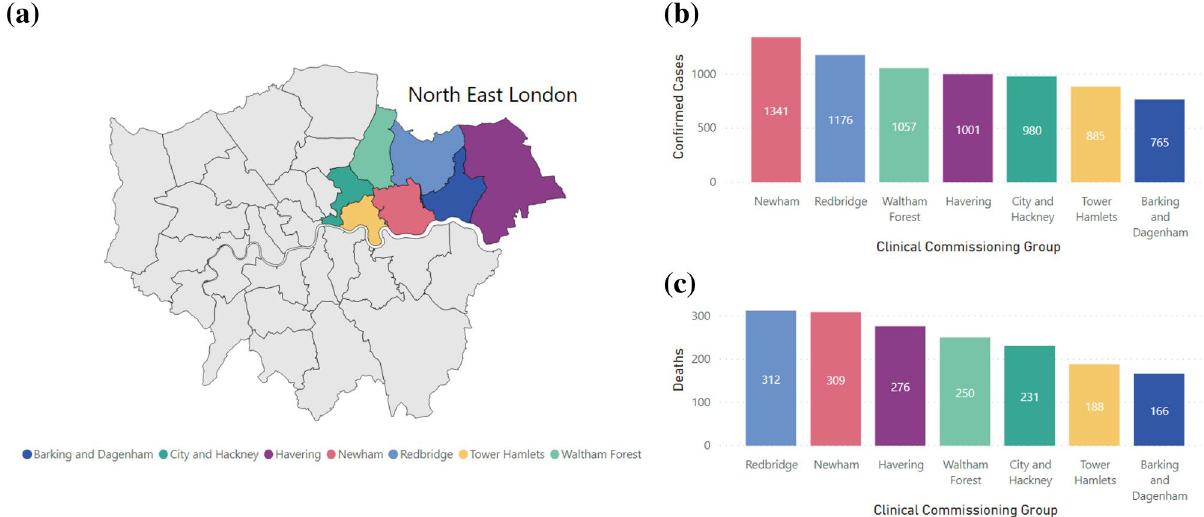
Figure 1. ( a ) NHS Clinical Commissioning Group (CCG) London boundaries, with North East London CCGs highlighted. ( b ) Number of confirmed cases of COVID-19 for North East London Clinical Commissioning Groups, up to 3rd August 2020 3 . ( c ) Number of deaths due to COVID-19 for North East London